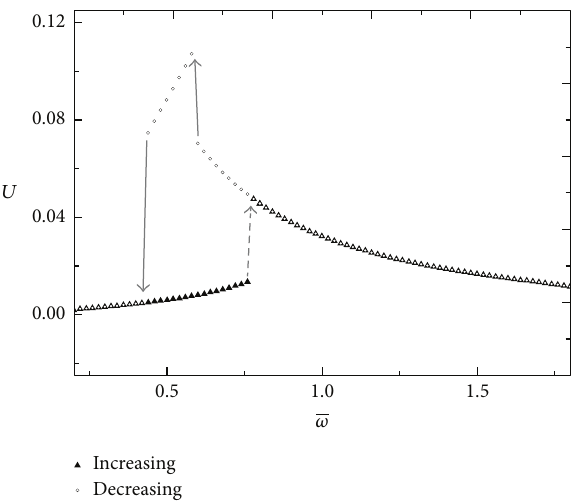
Increasing Figure 2: Maximum system amplitude with V = 0.025 m/s and a sine sweep of the forcing